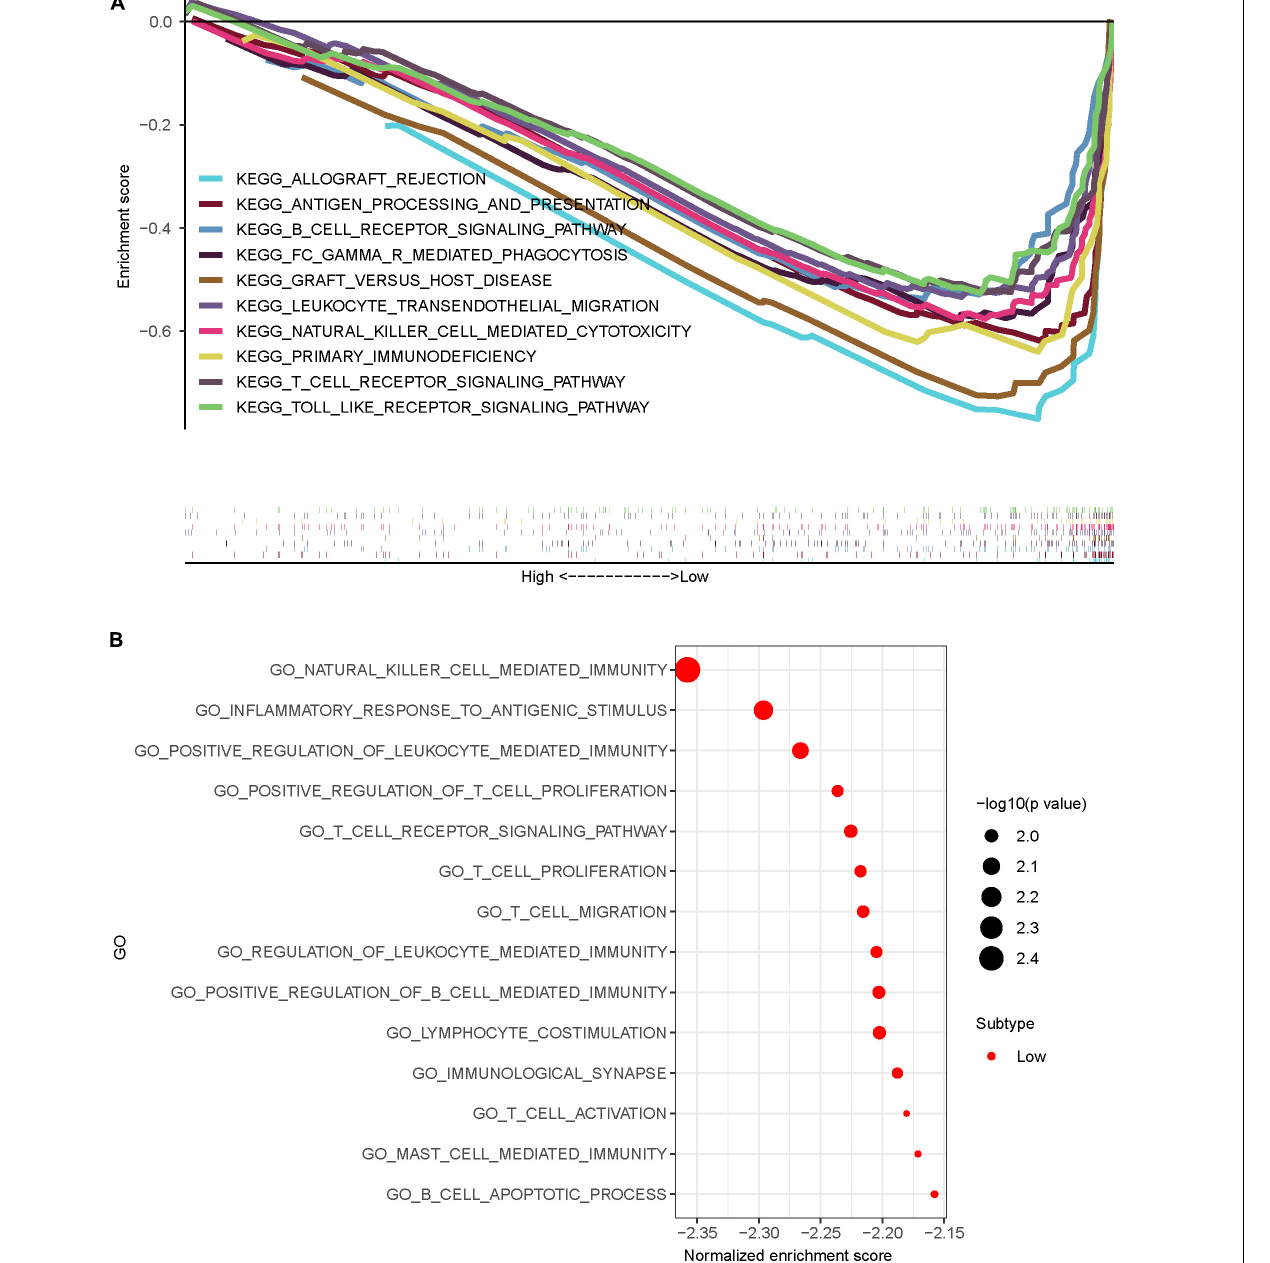
AC016746.1, LINC01976, and SNHG6 was not conducive to the prognosis of osteosarcoma ( Figure 2D and Supplementary Figure 1B ). Cox regression analysis showed that AL133523.1, AC079760.2, and LINC01976 were independent prognostic factors for osteosarcoma ( Supplementary Tables 5 , 6 and Supplementary Figure 2